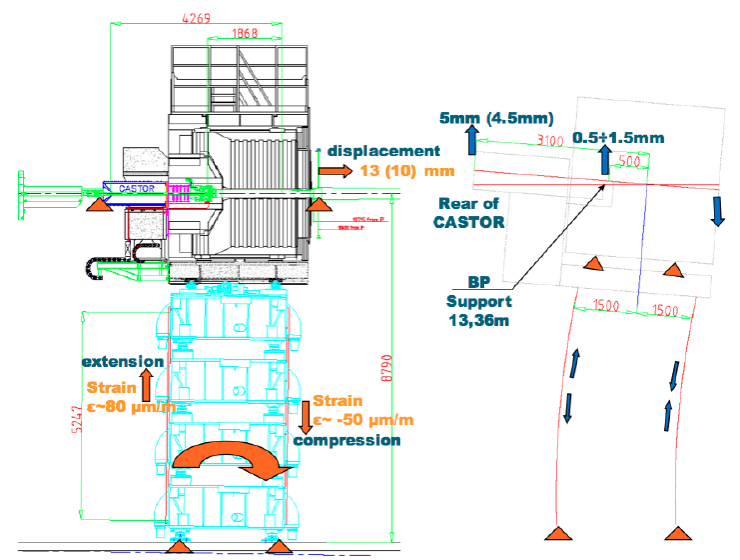
Figure 24. Morphing of the HF raiser and platform structure computed from the FBGs strain data.